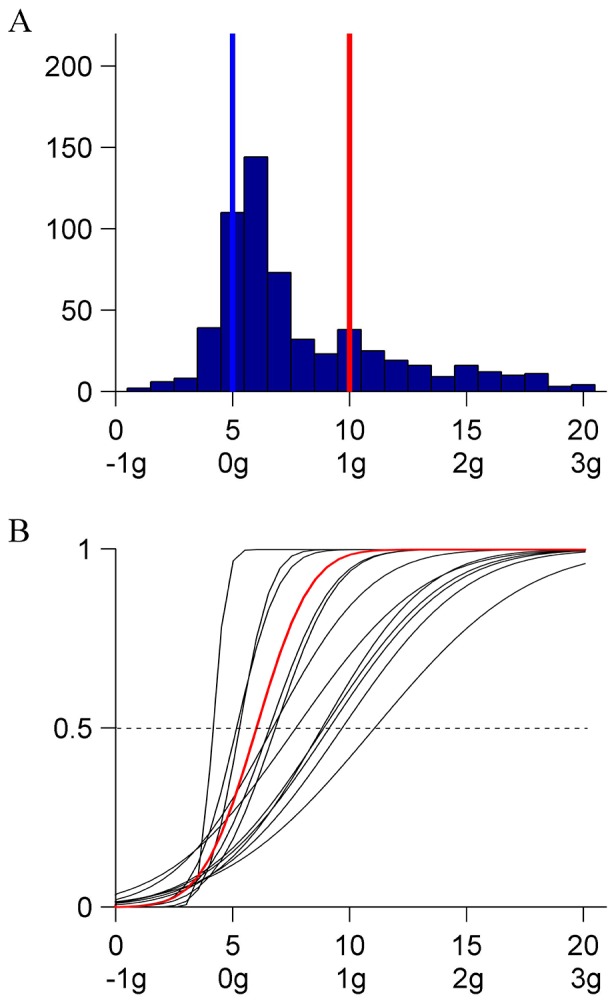
Experiment 5 (linear vertical unidirectional).A: Distribution histogram of the responses (pooled over participants). B: CDFs for each participant and for the population. Same format as in Figure 2B.